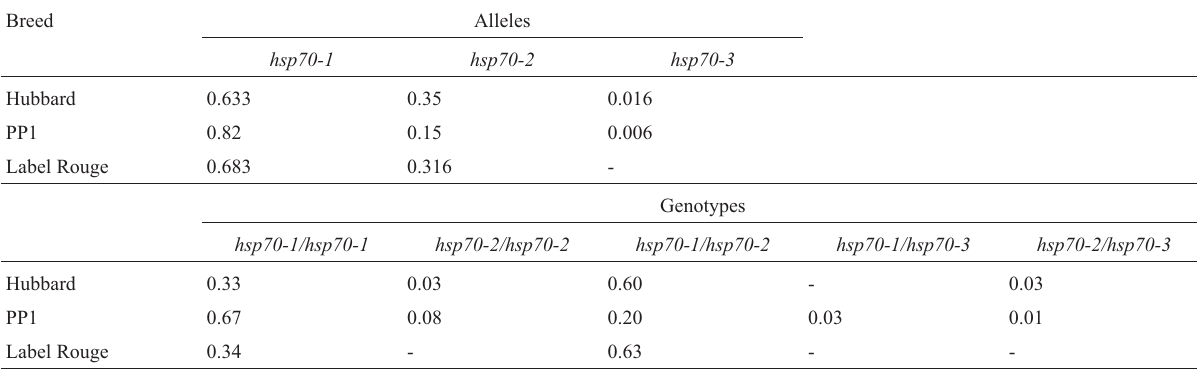
Table 2 - Allelic and genotypic frequencies observed for each breed (n = 30 for Hubbard and Label Rouge and n = 90 for PP1). Breed